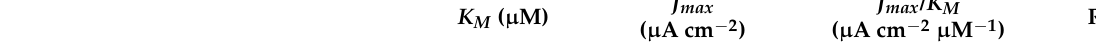
Table 2. Kinetic parameters for the electrocatalytic reduction of H 2 O 2 carried out by wt beef heart cytochrome c (bcc), wt yeast iso-1 cytochrome c (ycc) and its K79A, K73A, K72A/K73A, K72A/K73A/K79A, K72A/K73H/K79A, M80A, M80A/Y67A, and M80A/Y67H variants adsorbed on a polycrystalline gold electrode coated with a SAM of MUA/MU or 1-DT. For the solution composition, experimental conditions, and uncertainties associated with the reported values, the reader is referred to the original